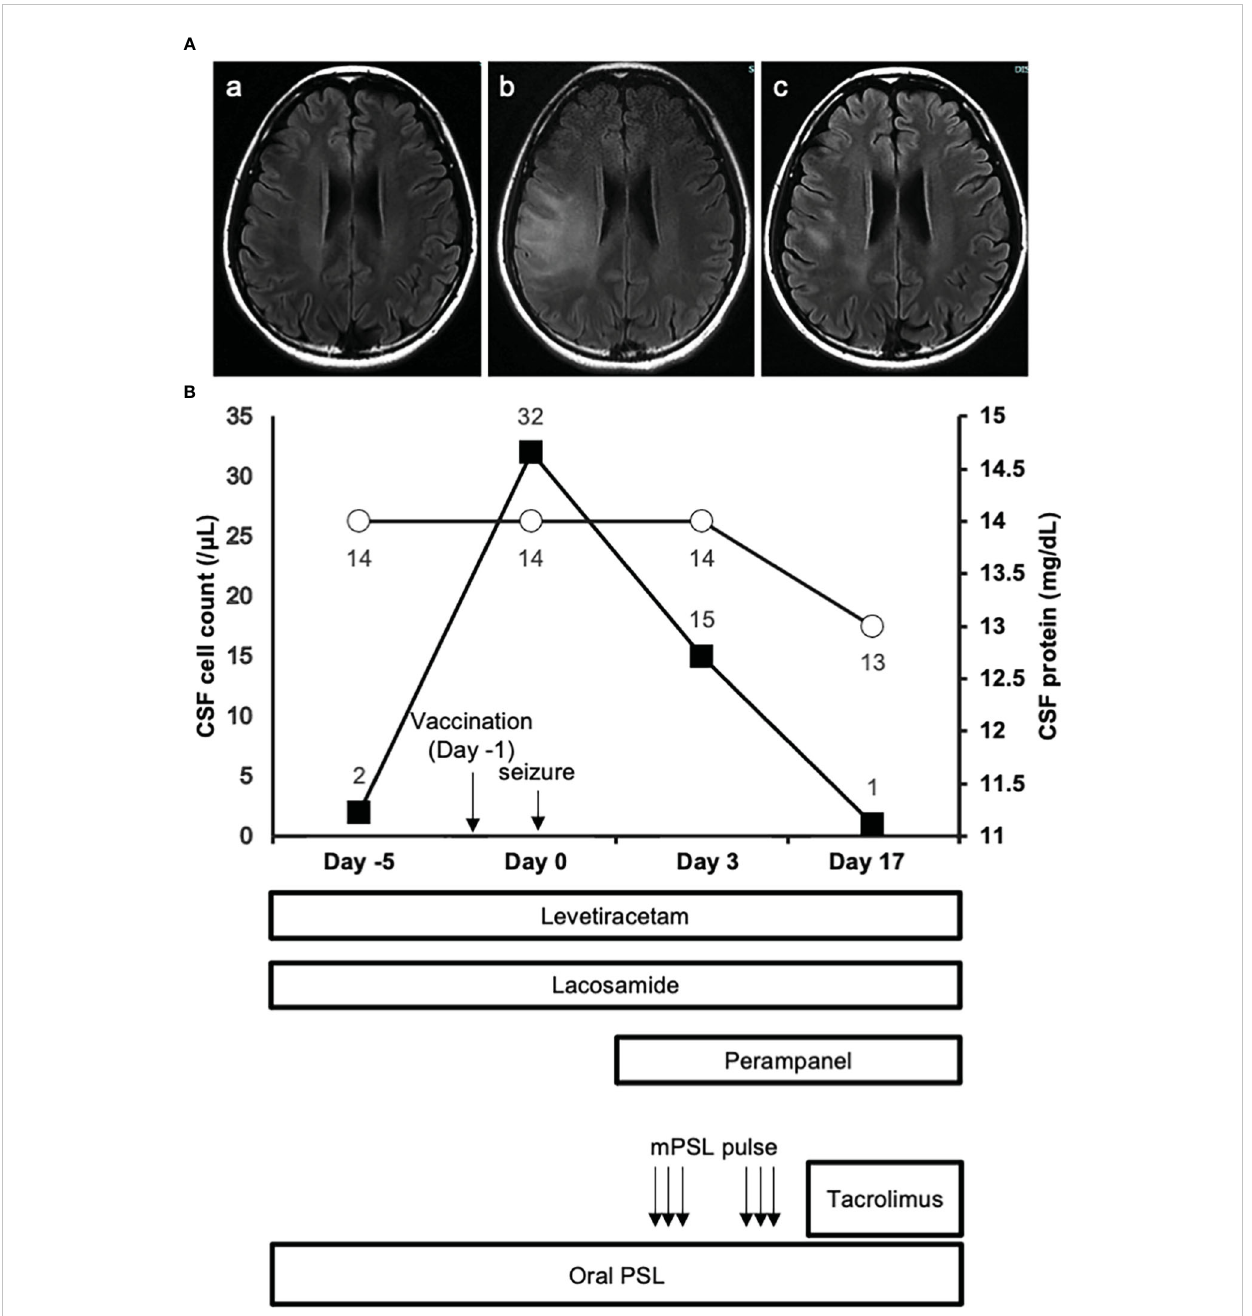
FIGURE 1 MRI images and clinical course. (A.a) FLAIR image of the brain obtained 2 days before the vaccination. (A.b) FLAIR image of the brain on day 0 show extensive development of high intensity lesions predominantly at the white matter. (A.c) FLAIR image of the brain on day 24 reveals the amelioration of high intensity lesions observed at the acute phase of the disease. (B) The closed squares and open circles represent CSF cell count and protein concentration of each timepoint